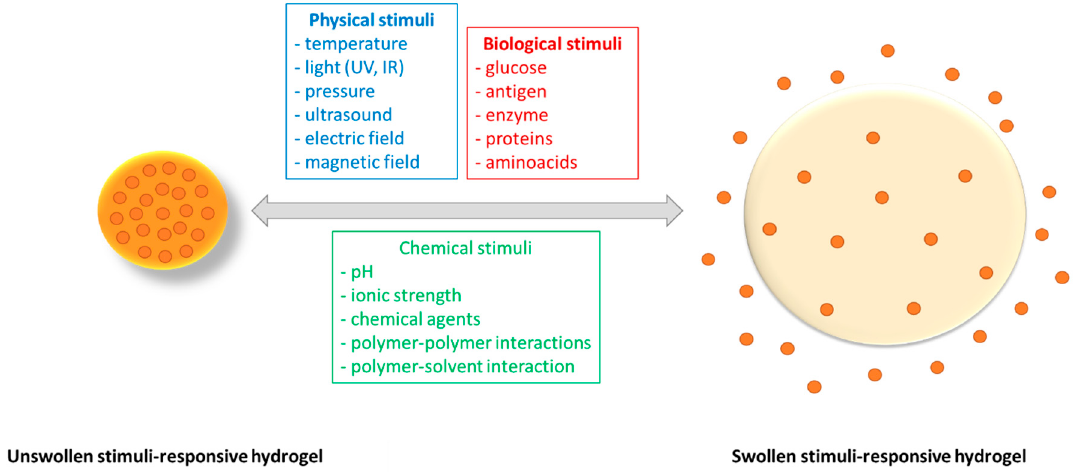
Figure 7. The schematic representation of stimuli-responsive hydrogels.